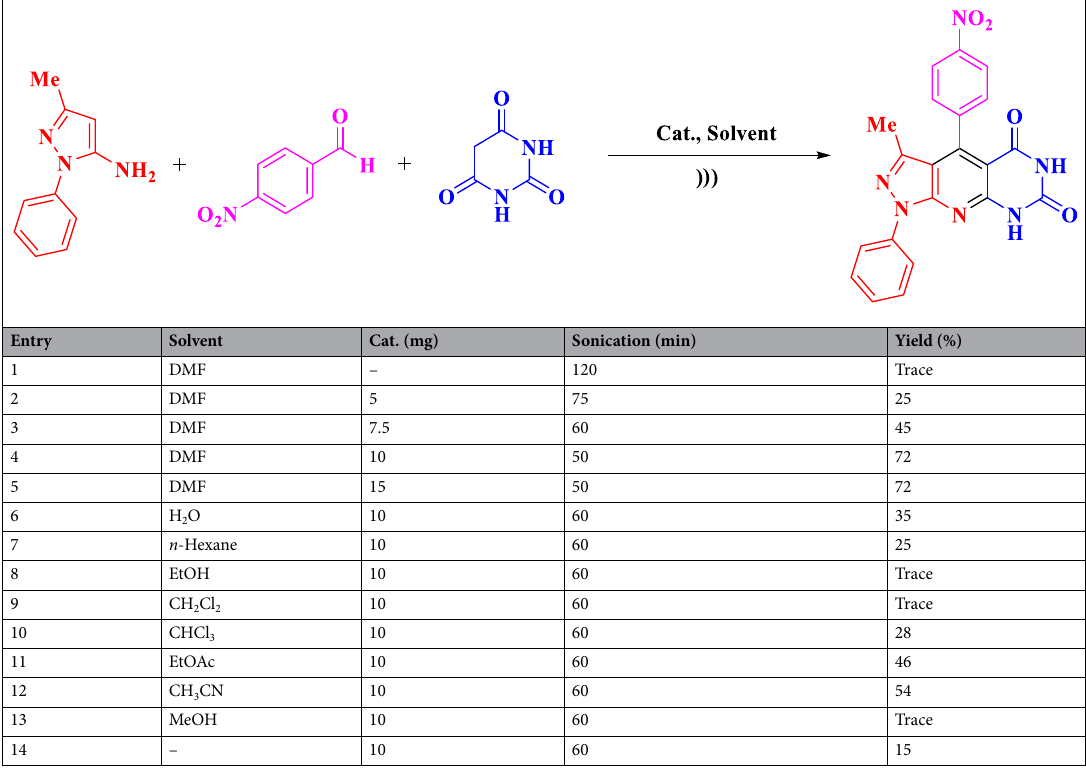
Table 1. Effect of different amounts of catalysts and solvent (5 mL) in the synthesis of novel fused pyridines and 1,4-dihydropyridines with pyrazole and pyrimidine moieties by using the corresponding precursors